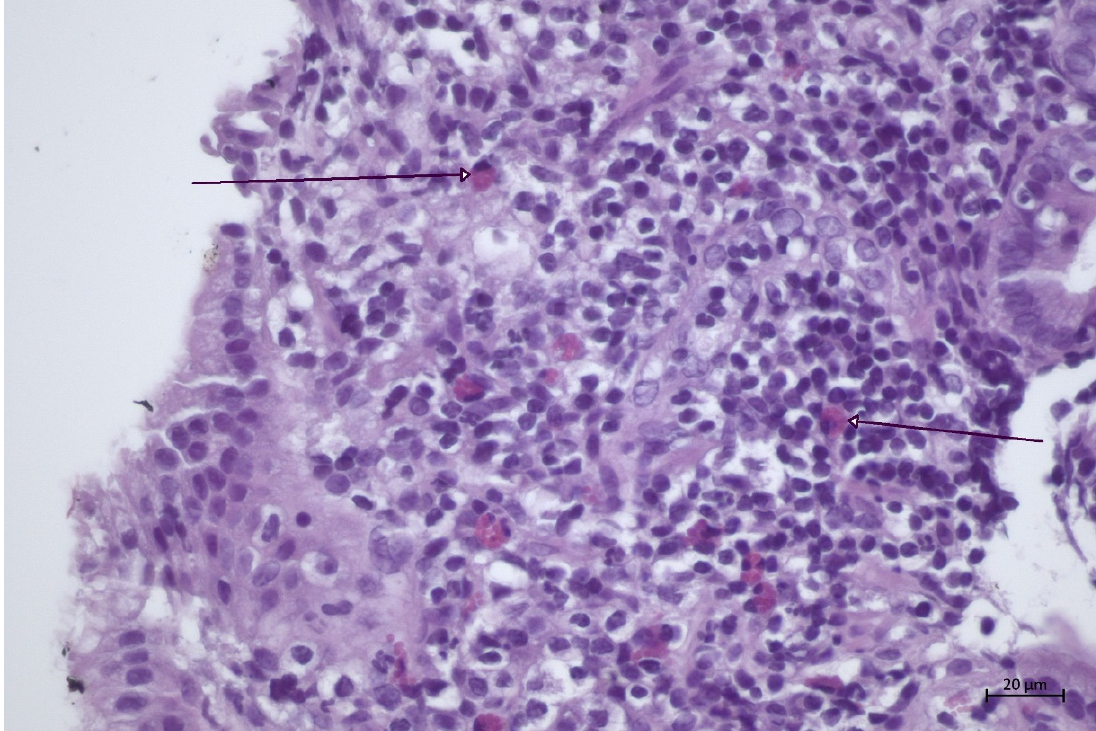
Figure 4. Histopathological image of a horse diagnosed with moderate subacute to chronic non- ulcerative duodenitis. Mott’s cells are marked with an arrow. Magnification 600×.